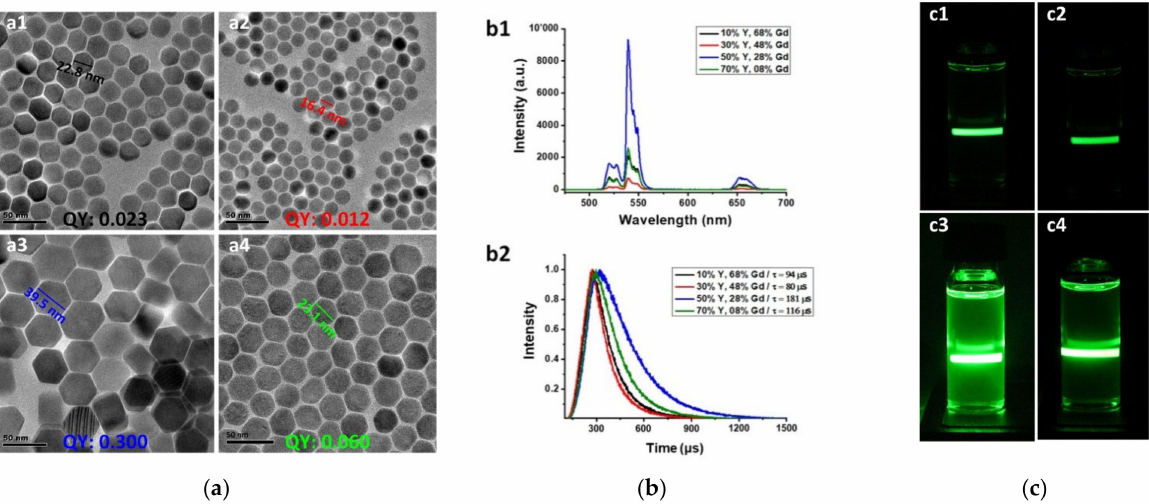
Figure 1. ( a ) TEM micrographs of as-synthesized UCNPs composed of different ratios of identical precursors of various sizes; pertinent sizes and QYs are noted. Room-temperature ( b1 ) upconversion emission spectra and ( b2 ) lifetime of core–shell β - NaGd α 1 Y β F 4 :Yb,Er@NaGd α 2 Y β F 4 :Yb@NaGd α 3 Y β F 4 :Yb NPs (black: α 1, 2, and 3, respectively = 68, 70, and 70%/ β = 10%; red: α 1, 2, and 3, respectively = 48, 50, and 50%/ β = 30%; blue: α 1, 2, and 3, respectively = 28, 30, and 30%/ β = 50%; green: α 1, 2, and 3, respectively = 8, 10, and 10%/ β = 70%; 20 mg/mL) under excitation of 980 nm; ( c ) photographs of as-synthesized UCNPs composed of different ratios of identical precursors that produce various fluorescence intensities against a 980 nm CW laser. Scale bars: 50